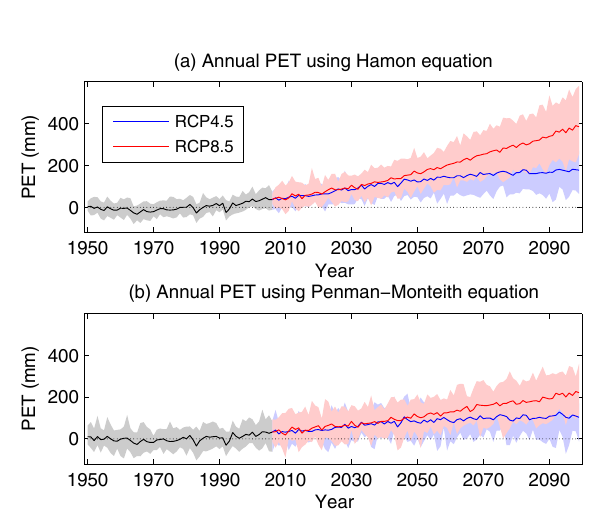
Figure 4. Temporal variations of changes in annual potential evap- otranspiration (PET) over the CONUS against the baseline level (1970–1999). Thick lines and the shading denote the ensemble means and uncertainty ranges of the 20 GCMs,